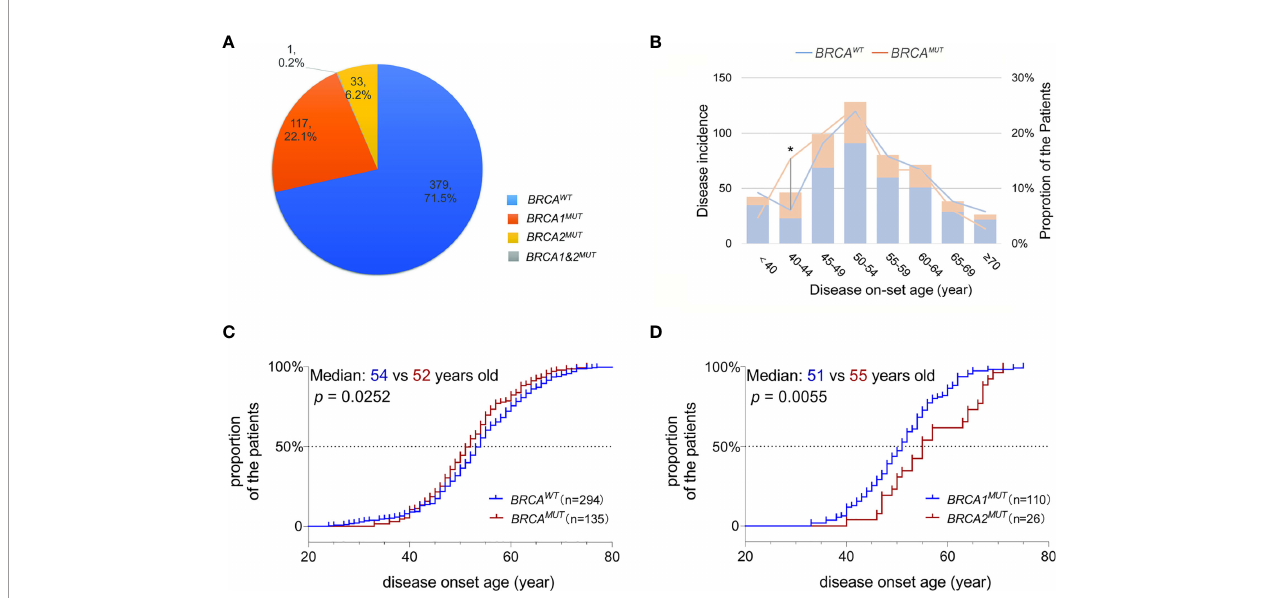
FIGURE 1 | BRCA mutations associated with disease on-set age of OC. (A) A pie plot shows the number and proportion of BRCA1 and BRCA2 germline mutation carriers in 530 Henan OC patients. WT, wild-type; MUT, mutation. (B) Incidence (left Y-axis) and proportion of the patients developed serous OC (right Y-axis) at de fi ned age (X-axis) in BRCA MUT (orange) and BRCA WT (blue) carriers. A chi-square test was used to determine whether the frequency of OC incidence is different between BRCA MUT and BRCA WT carriers of 40 – 44 years old. * p < 0.05. (C) Comparison of the disease on-set age of serous OC between BRCA MUT versus BRCA WT carriers, and BRCA1 MUT versus BRCA2 MUT carriers (D) by plotting the cumulative incidence curve. A log-ranked test was used to compare the difference in disease on-set age between different groups, and a p -value of < 0.05 was considered as signi fi